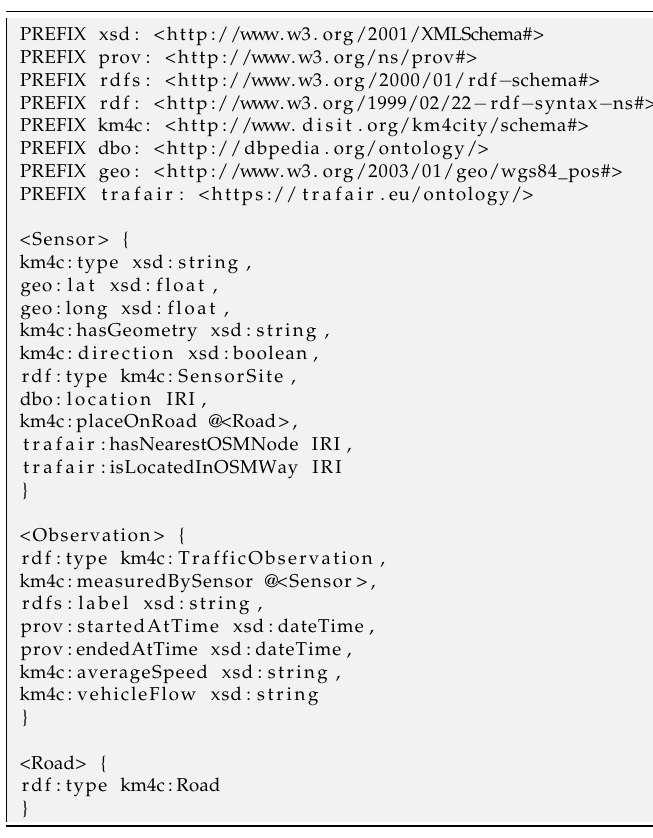
Figure A1. Data Model described though Shape